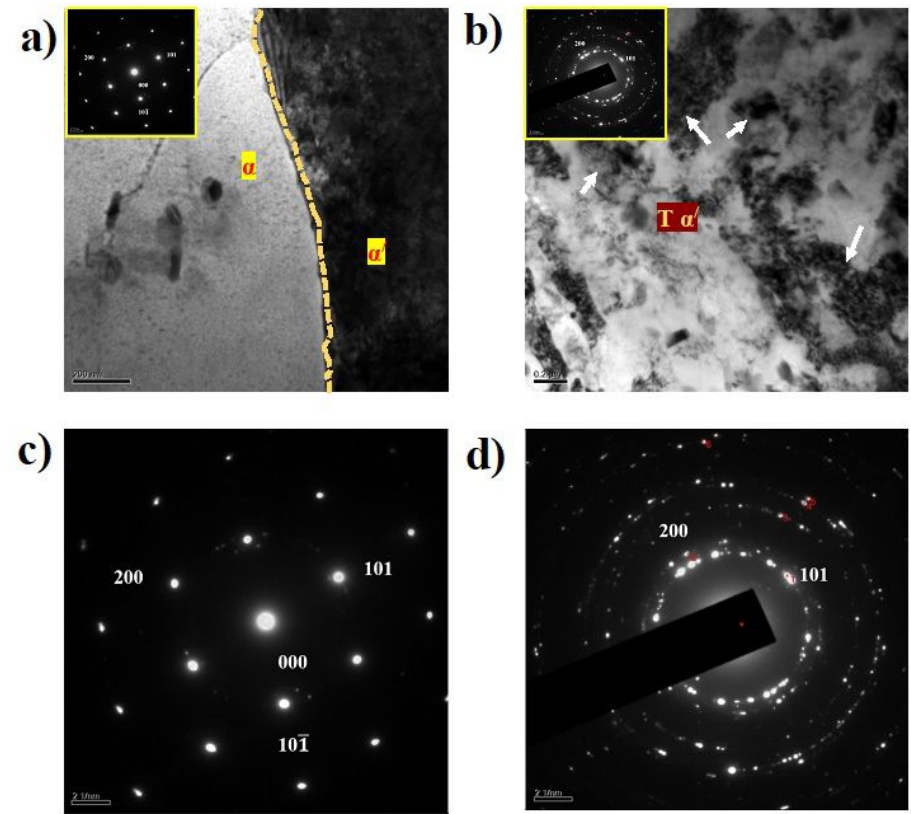
Figure 13: TEM microstructural features of weld nugget: a) NZ; b) HAZ; c) SAD pattern of NZ and d) SAD pattern of HAZ